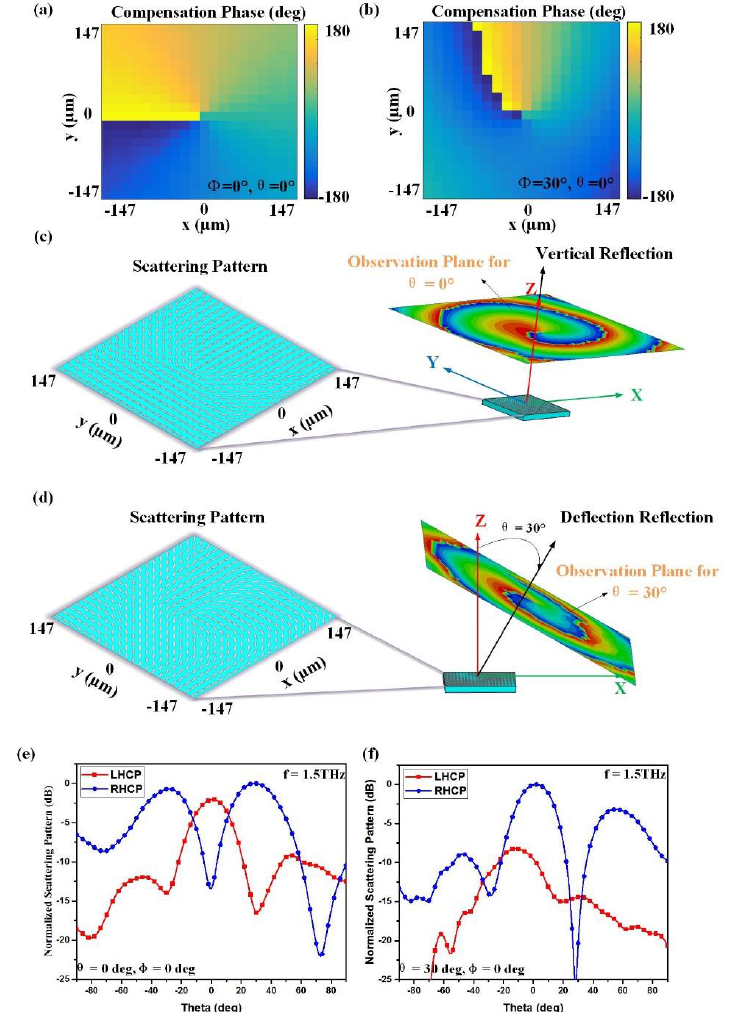
Figure 9. Simulation results for generating a spin-controlled OAM beam with L = 1 in arbitrary directions: ( a , c , e ) The required compensation phase distribution, scattering pattern of the metasurface and normalized scattering pattern in (0 ◦ , 0 ◦ ) direction; ( b , d , f ) the required compensation phase distribution, scattering pattern of the metasurface and normalized scattering pattern in (30 ◦ , 0 ◦ )